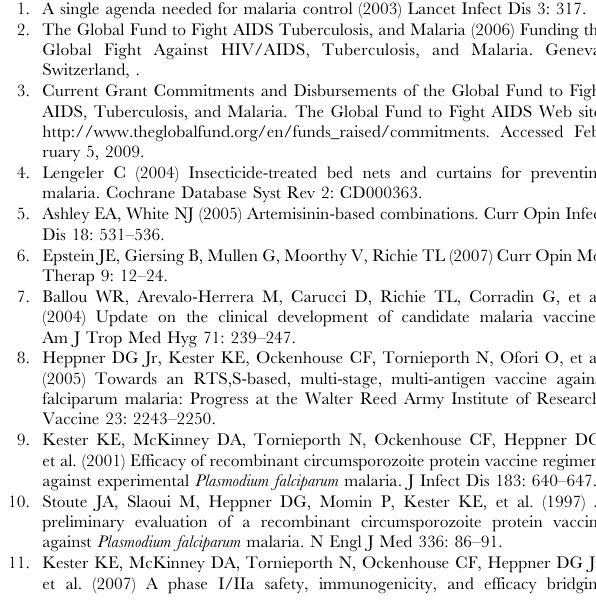
Table S3 Th2R and Th3R haplotype prevalence at baseline and among ADI